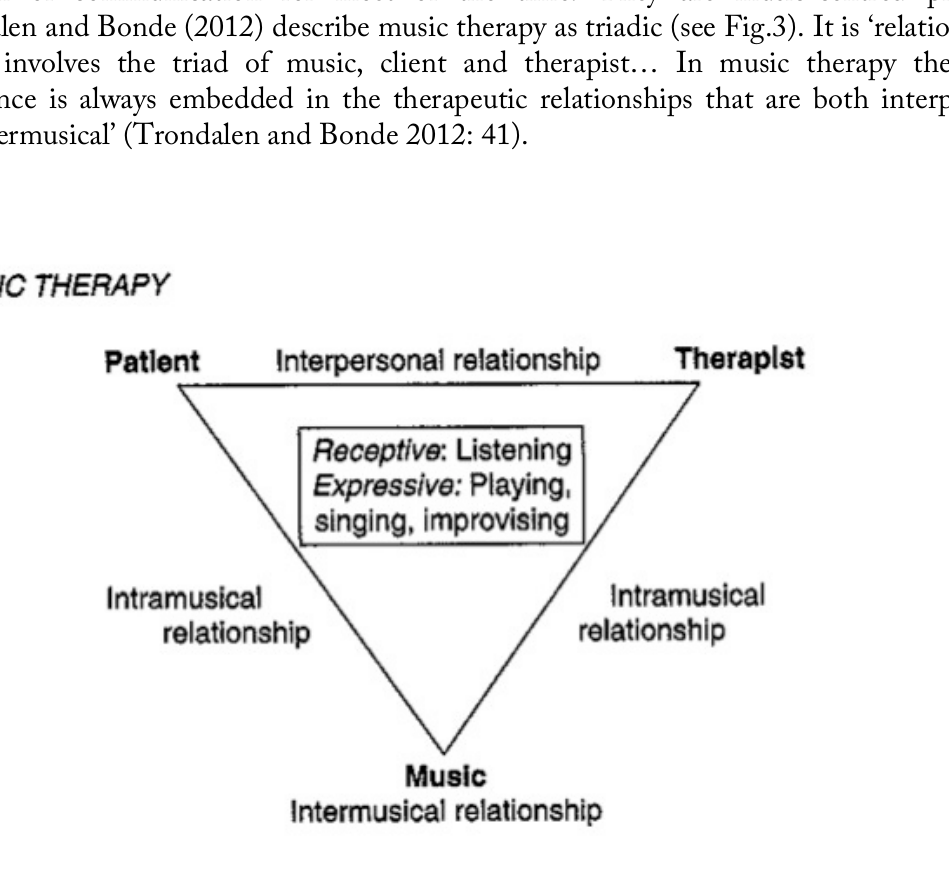
Fig.3 Elements and relationships in music therapy. From Trondalen and Bonde (2012: